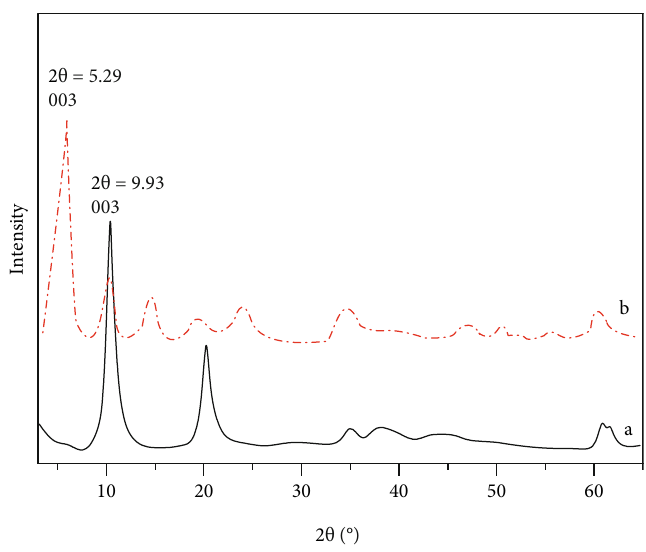
Figure 2: The powder XRD patterns of (a) LDH and (b) LDH-[Ni(EDTA)] -2